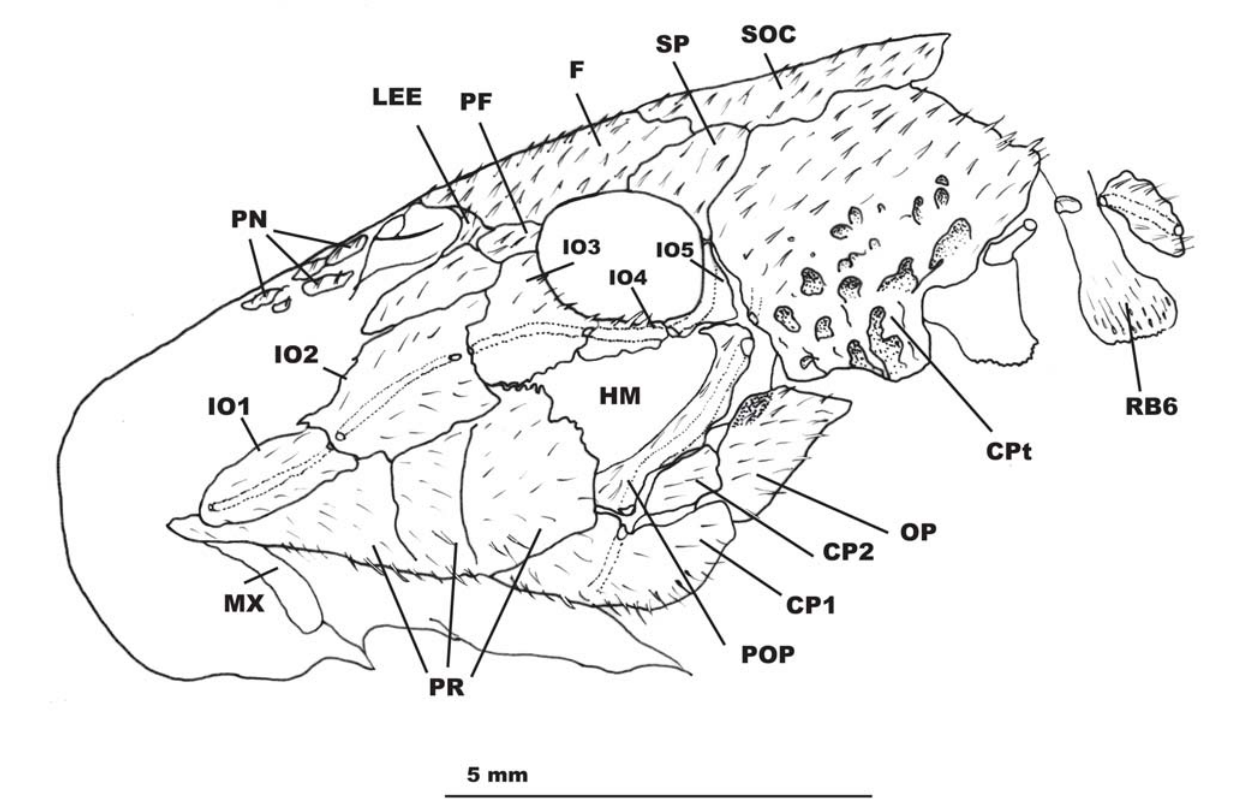
Fig. 8. Skull in lateral view of Gymnotocinclus anosteos , MCP 41726, paratype, male, 40.5